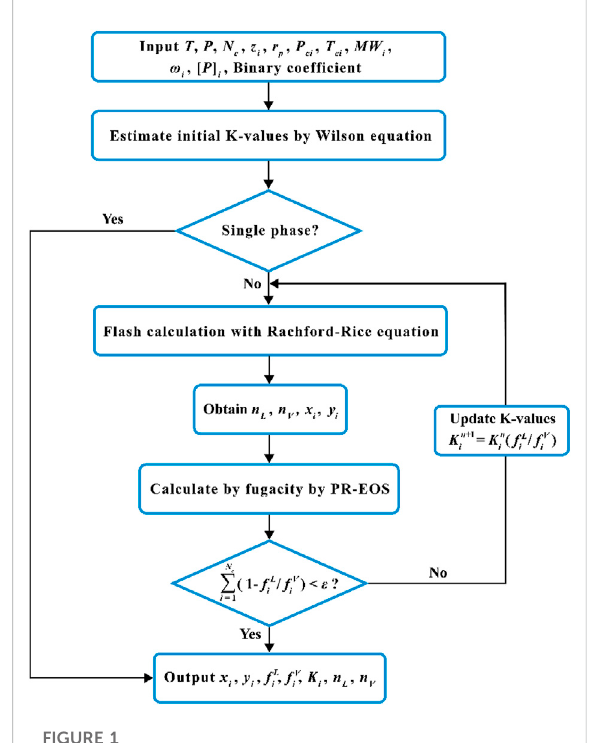
FIGURE 1 Flow char for two-phase fl ash calculations with